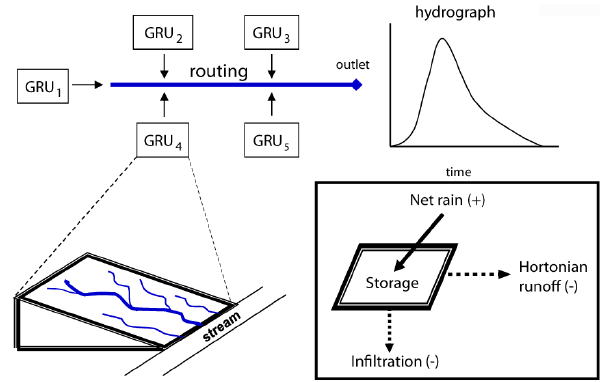
Fig. 1. Schematic representation of the modelling framework used in the study. The Hortonian runoff generating processes for individ- ual GRUs defined in the closure relation are shown in concept in the box. The plus and minus signs indicate incoming and outgoing fluxes of the GRUs,